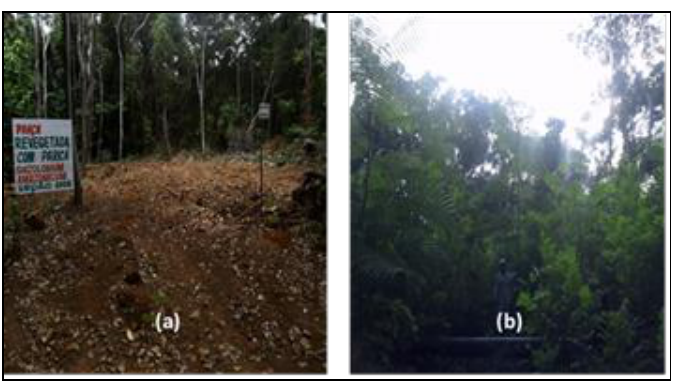
Figure 5: (a) Impacted area due to the geological survey, after the 1st day of planting the consortium paricá and braquiarão; (b) Search area recovered after 6 months of planting restored the phytosociology.